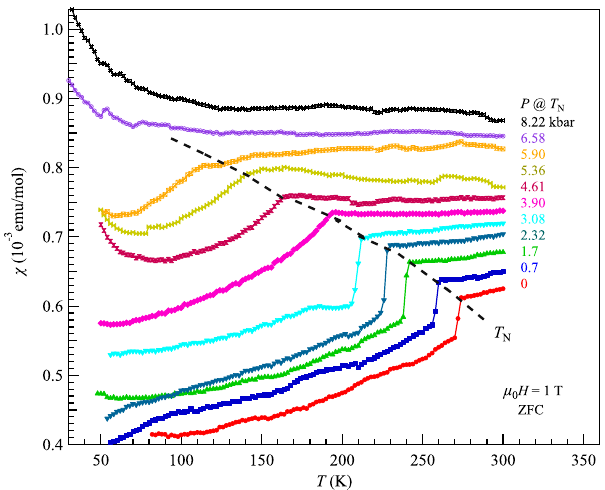
FIG. 4. Temperature dependence of the dc magnetic suscep- tibility χ ð T Þ of CrAs single crystals under various hydrostatic pressures up to 8 kbar. Except the χ ð T Þ curve at 1 bar, all curves have been shifted above for